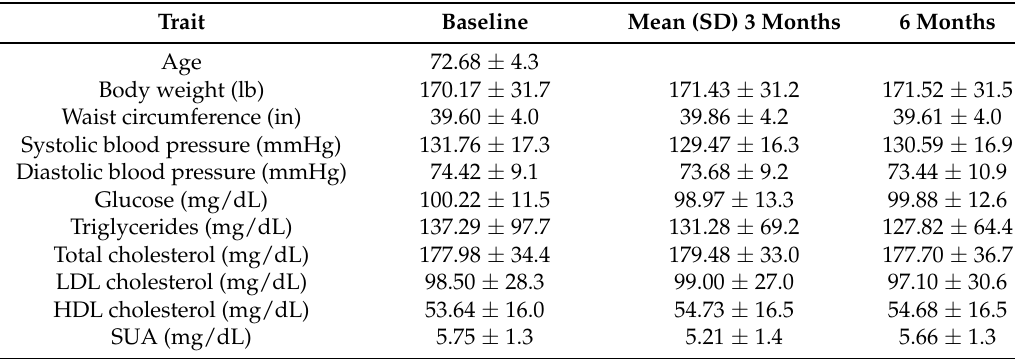
Table 2. Descriptive statistics at baseline, 3 months, and 6